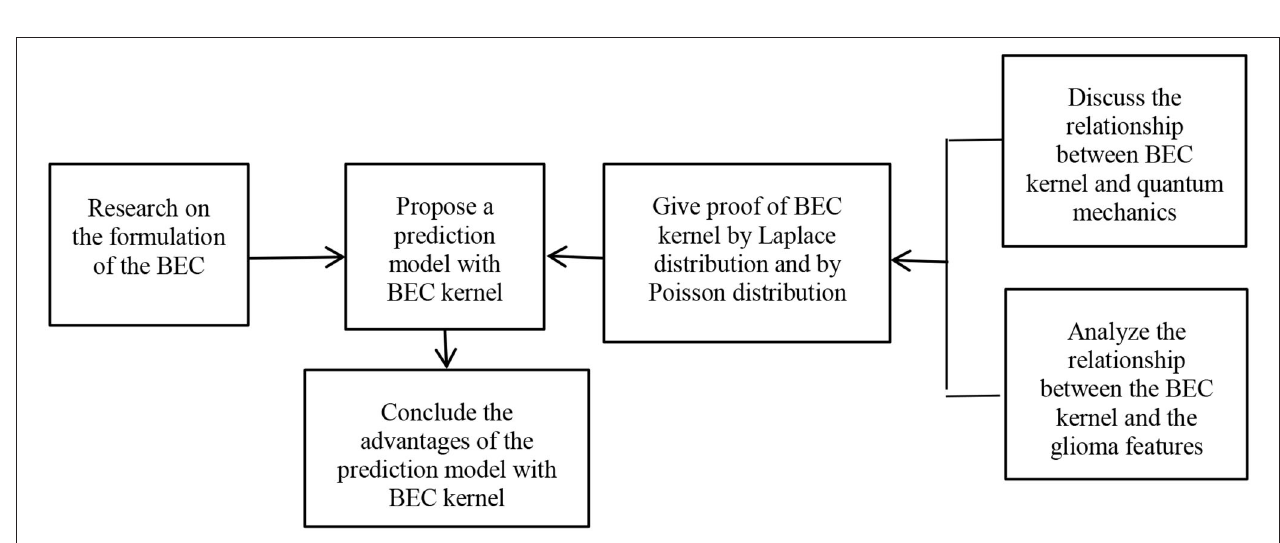
FIGURE 3 | The framework of the proposed method.